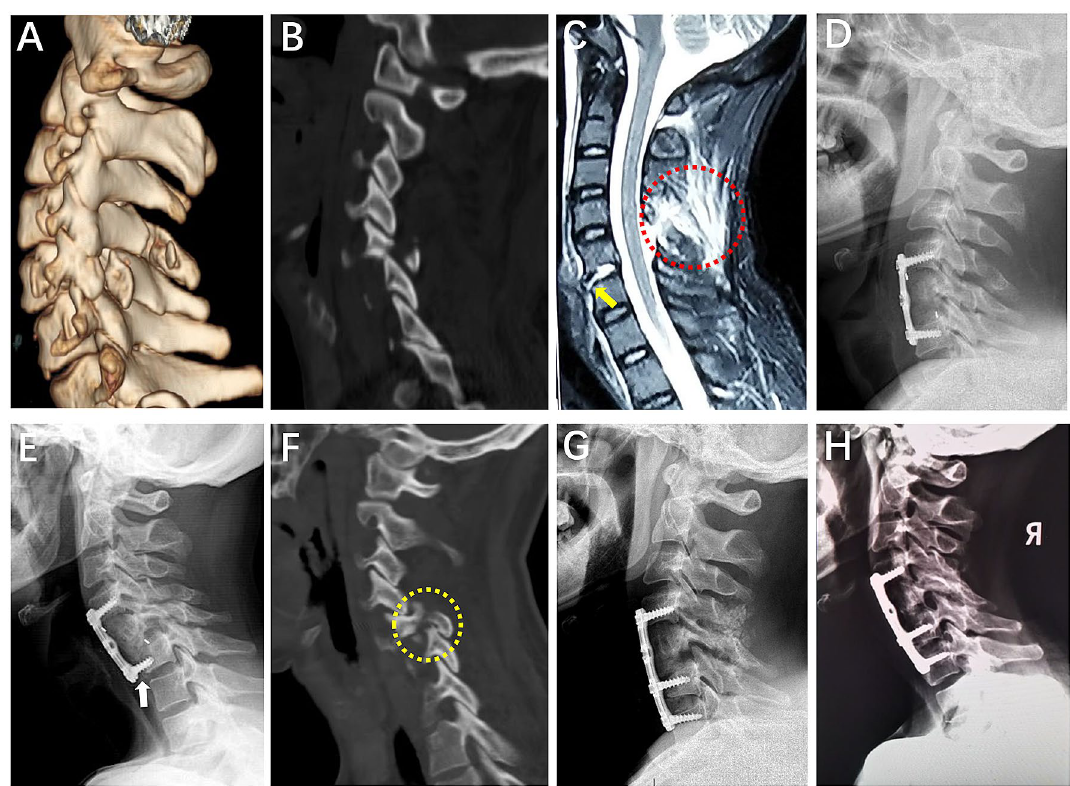
Figure 5. A 40-year-old man who was diagnosed as type IIB injury pattern of UCLF. Left side facet interlocking with ipsilateral inferior articular process fracture at C5-6 motion segment was discovered on CT three- dimensional reconstruction appearance ( A , B ). Sagittal T2-weighted MR image showed that the patient had a rupture of anterior longitudinal ligament and intervertebral disc (yellow arrow), and severe posterior ligament complex injury (red circle) ( C ). The patients had a successful closed reduction by preoperative skull traction, and anterior C5 corpectomy and fusion was performed ( D ). At 4 months follow-up after surgery, the patient had a sever neck pain and dysphagia due to failed reduction with migration of screws ( E ) and facet dislocation (yellow circle) at the injury segment ( F ). A revision surgery was performed by posterior facet release, reduction and autogenous bone fusion combined with extending the anterior fusion segment ( G ). The cervical spinal alignment was stable and the graft fusion was satisfactory at 20 months follow-up after revision surgery ( H